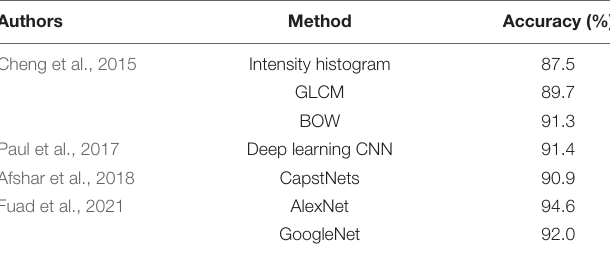
TABLE 1 | Comparison of recent architectures used for classification of brain cancer (adapted from Fuad et al., 2021).